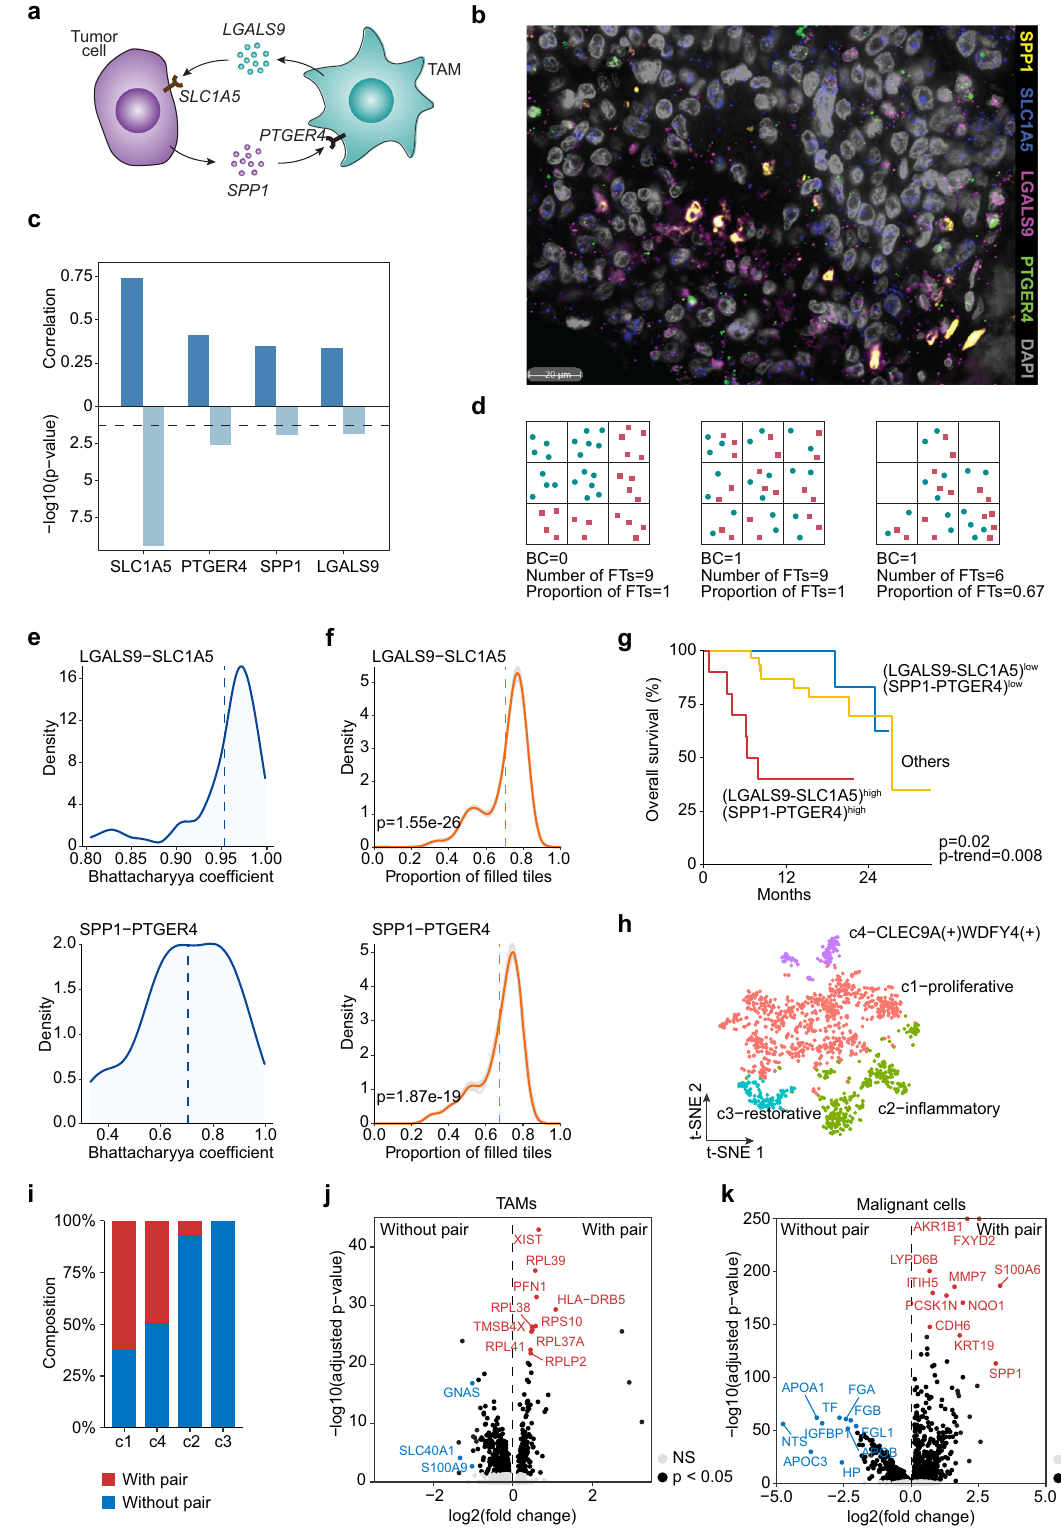
BC=1 Number of FTs=9 Proportion of FTs=1